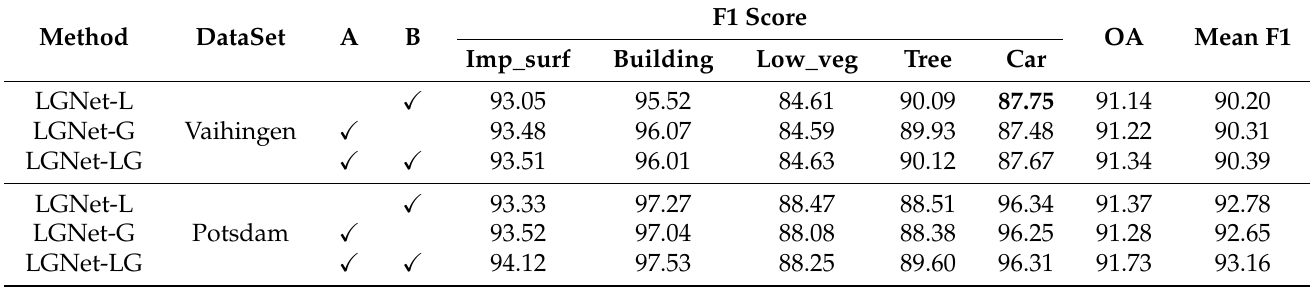
Table 3. The effect of trans-based global–local fusion module on the ISPRS Vaihingen and Potsdam